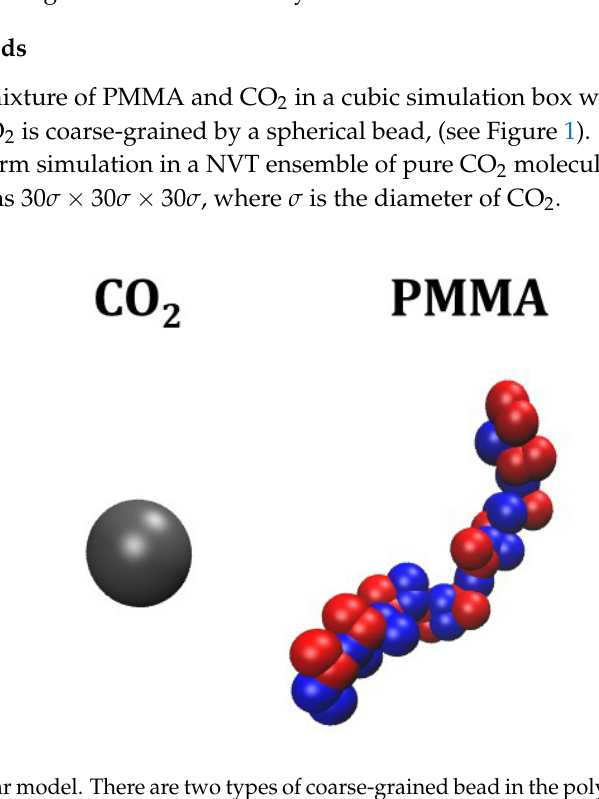
Figure 1. Molecular model. There are two types of coarse-grained bead in the poly(methyl methacrylate) (PMMA) chain. The main chain atoms form bead A (red color) and the ester side-group forms bead B (blue